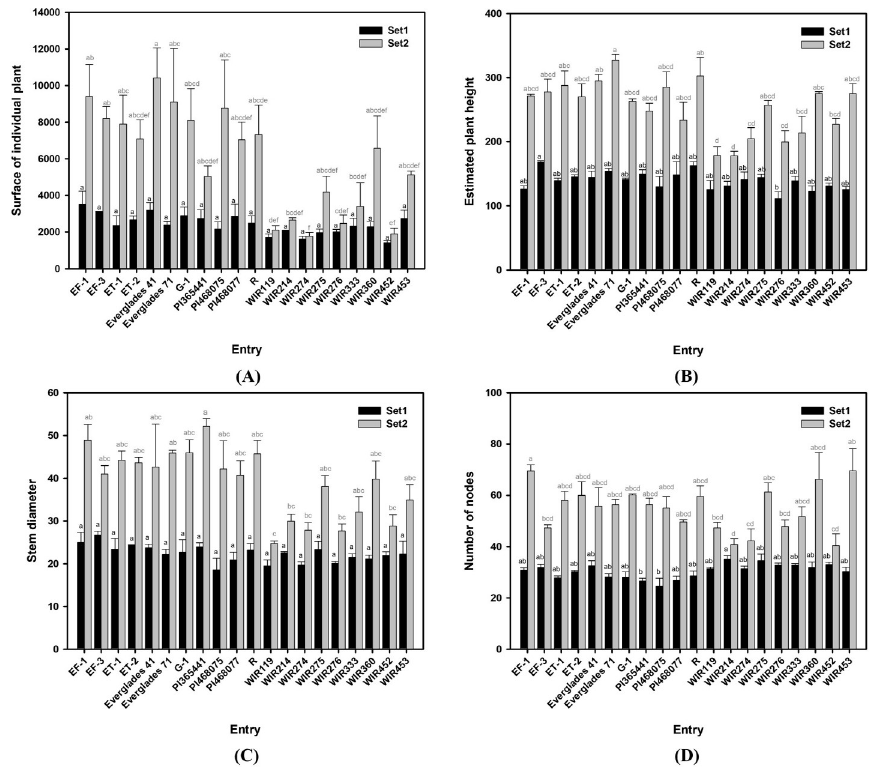
Fig 4. Variation of traits among kenaf ( Hibiscus cannabinus L.) entry two growth stage. (A) Surface of the individual plant (cm 2 ), (B) Expected plant height (mm), (C) Stem diameter (mm), and (D) Number of nodes of 20 kenaf entries at two different growth stages. Set 1 and Set 2 measured June 22 and August 31. The black bar and letter represent set 1, and the grey bar and letter represent set 2. Different letters on the bar are significantly different by Dunn test with Bonferroni adjustment. Non-parametric rank data were used for the statistical analysis; however, untransformed data are represented.